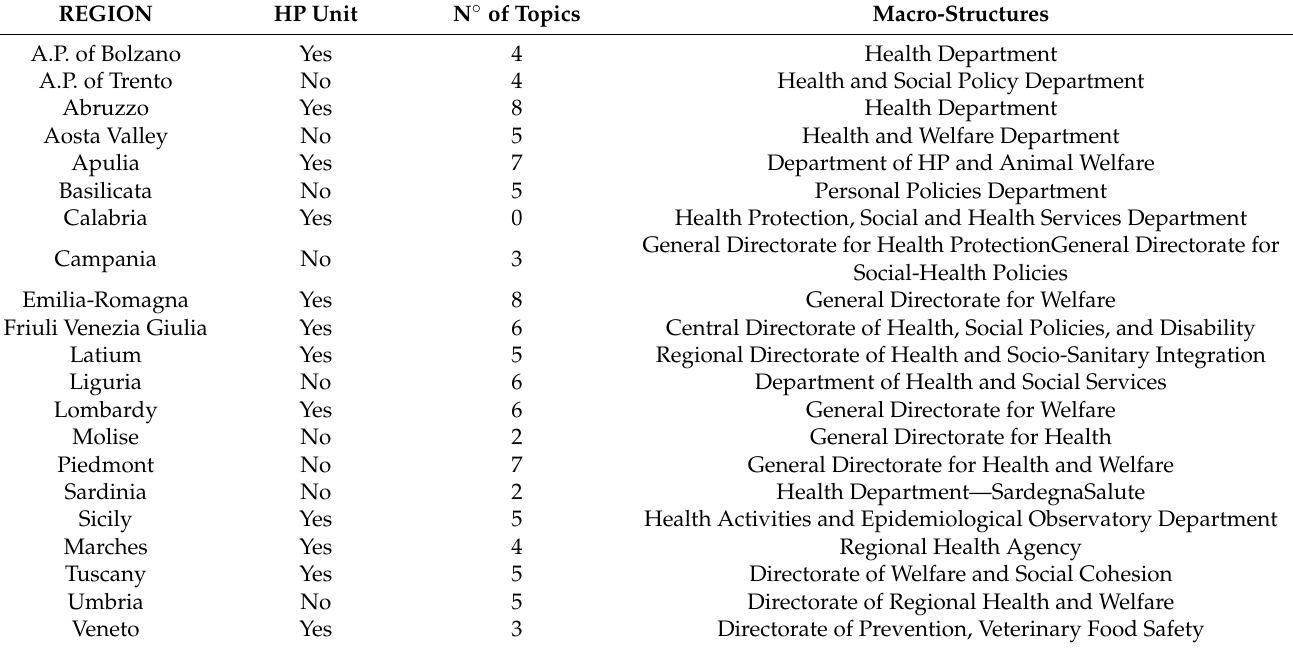
Table 1. Central structures specifically dedicated to HP in the departments of the Italian regions. REGION N ◦ of